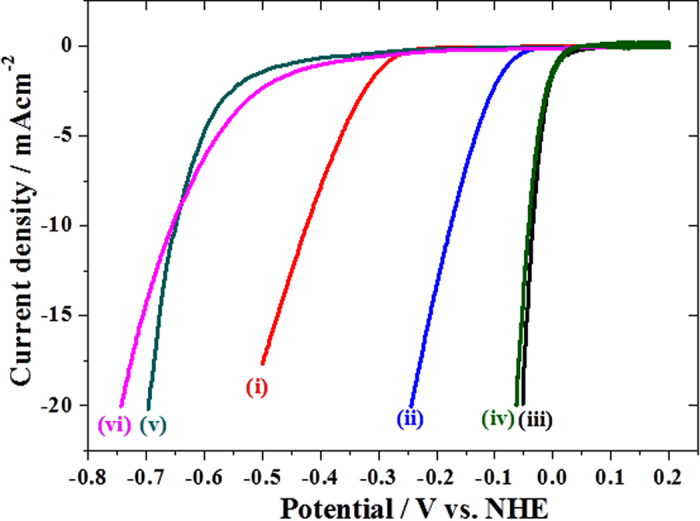
LSVs at (i) bare Au, (ii) BNNS/Au, (iii) bare Pt, (iv) BNNS/Pt, (v) Bare GC, and (vi) BNNS/GC in Ar saturated 0.5 M H2SO4 solution. Scan rate: 1 mVs−1.